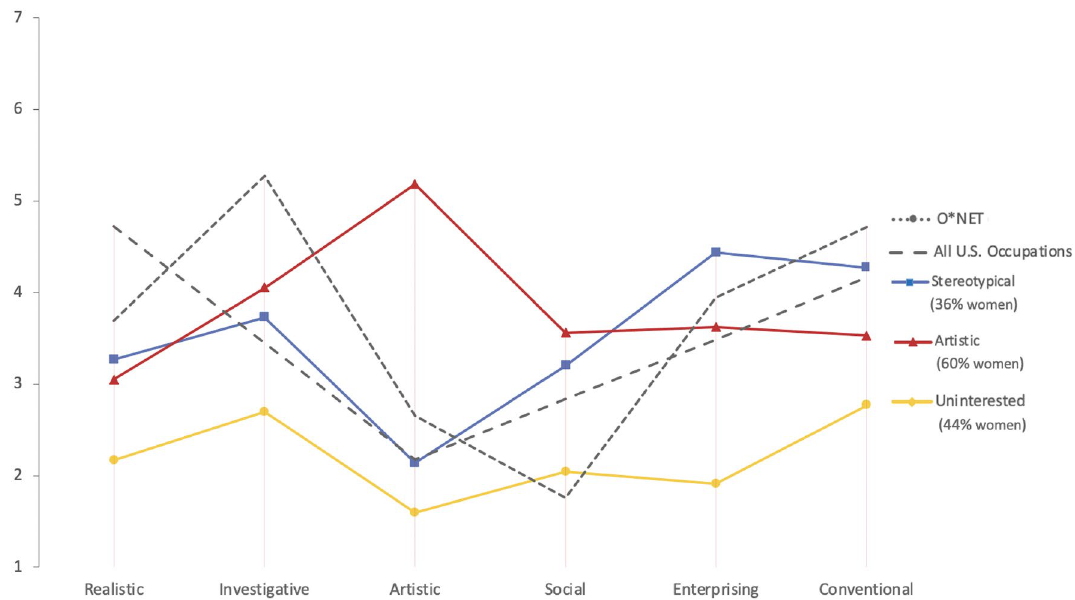
Figure 2. Interest Profiles of Those Aspiring to CS Compared to O*NET Estimations of CS Interests. Interests were assessed in both the online career interest survey and O*NET according to a scale from 1 to 7, with 7 indicating a stronger preference for/a greater relevance of that interest to the